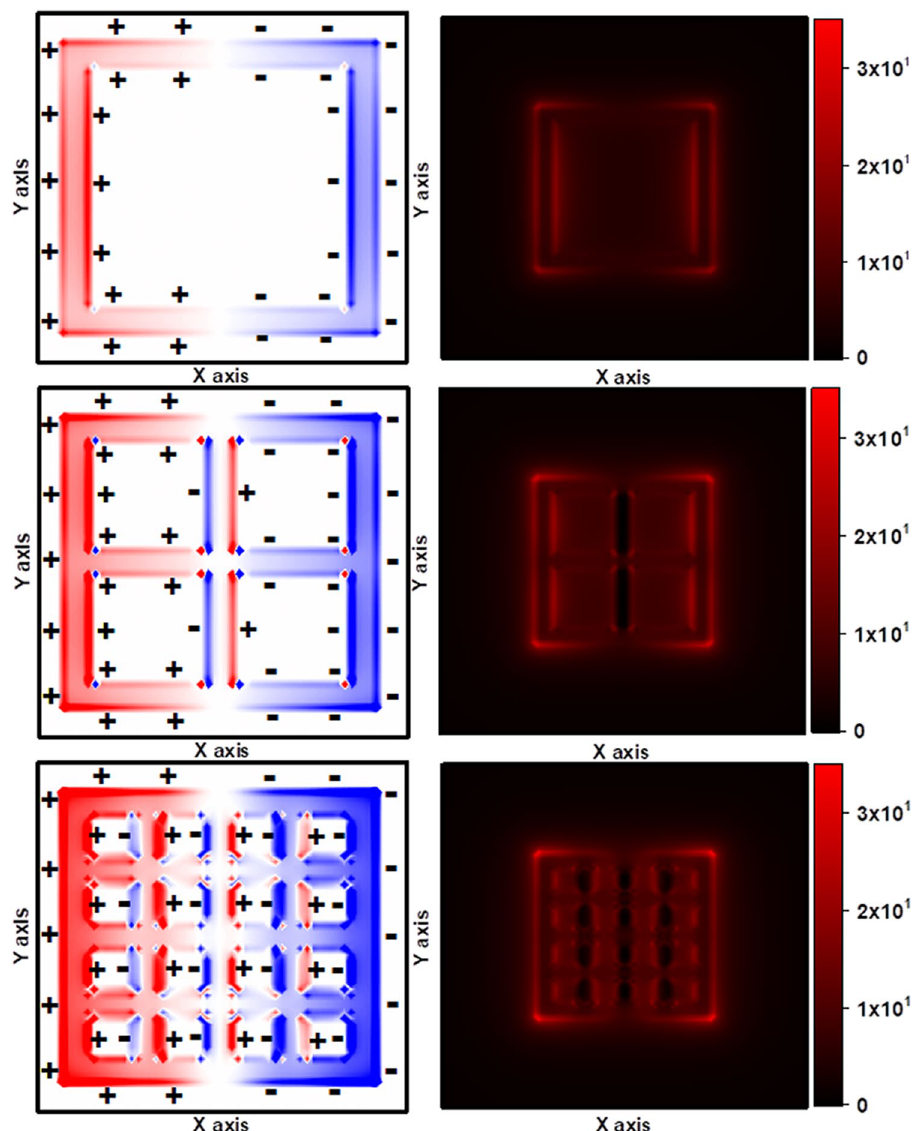
Figure 4. Charge density and near-field distribution of the cubic nanocage with q = 2 and 4 and nanoframe at the resonance wavelength. Symmetric and asymmetric modes of plasmon hybridization of facing surfaces are evident from the charge density map. Browser-based version of SketchUp, https ://app.sketc hup.com, and Origin 2020 version, https ://www.origi nlab.com, have been used for drawing images and making figures,